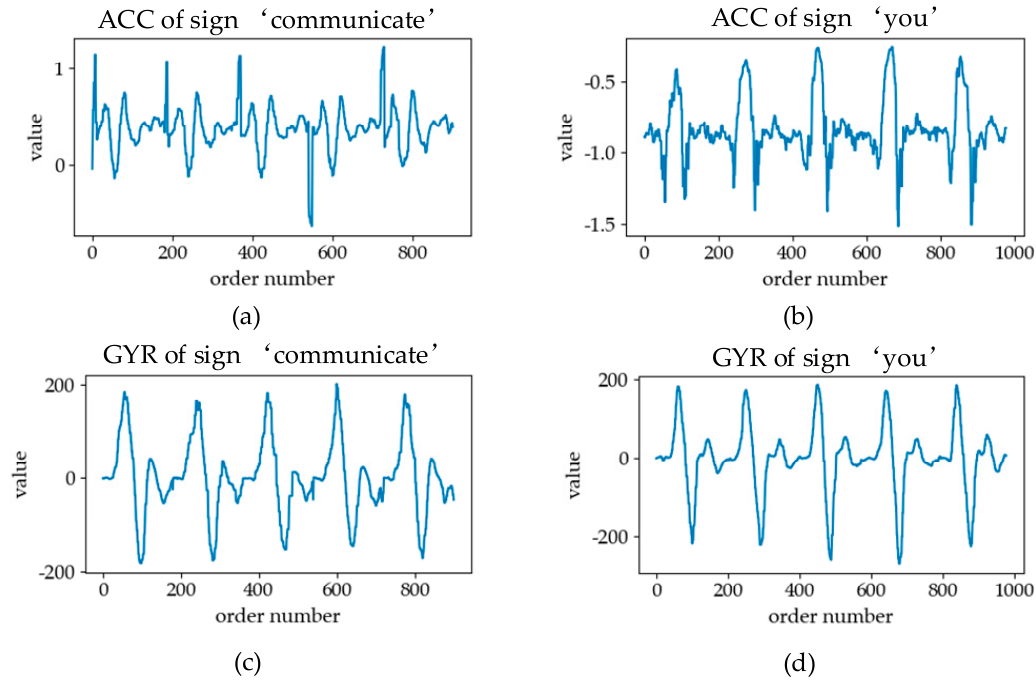
Figure 8. ACC and GYR signals in different sign languages: ( a , b ) are ACC signals of the signs “communication” and “you”; ( c , d ) are GYR signals of signs “communication” and “you”.